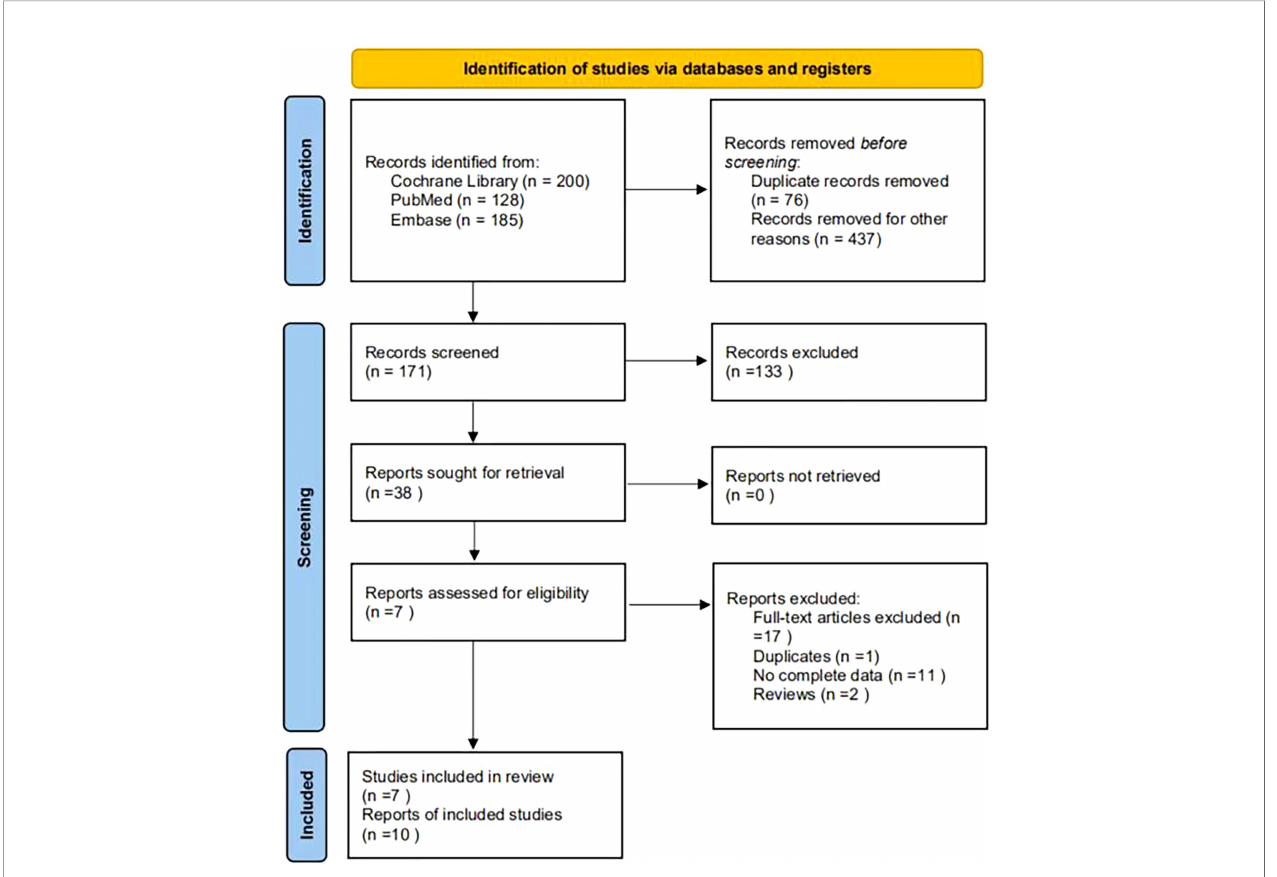
FIGURE 1 | Flow diagram of literature